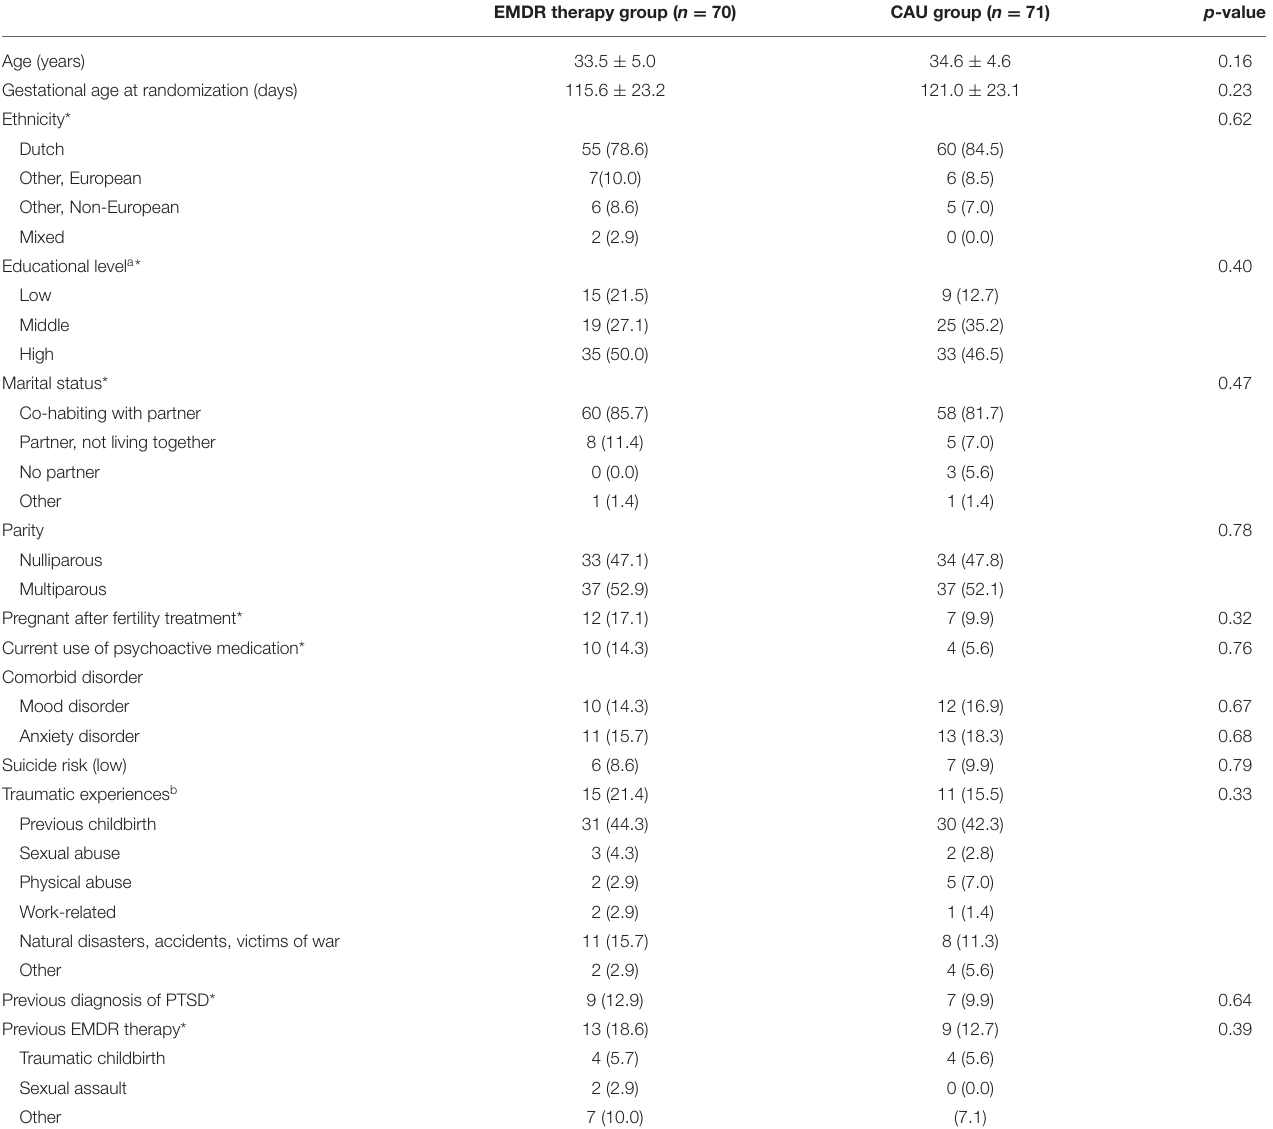
TABLE 1 | Demographic and clinical characteristics at baseline, mean ± SD or n